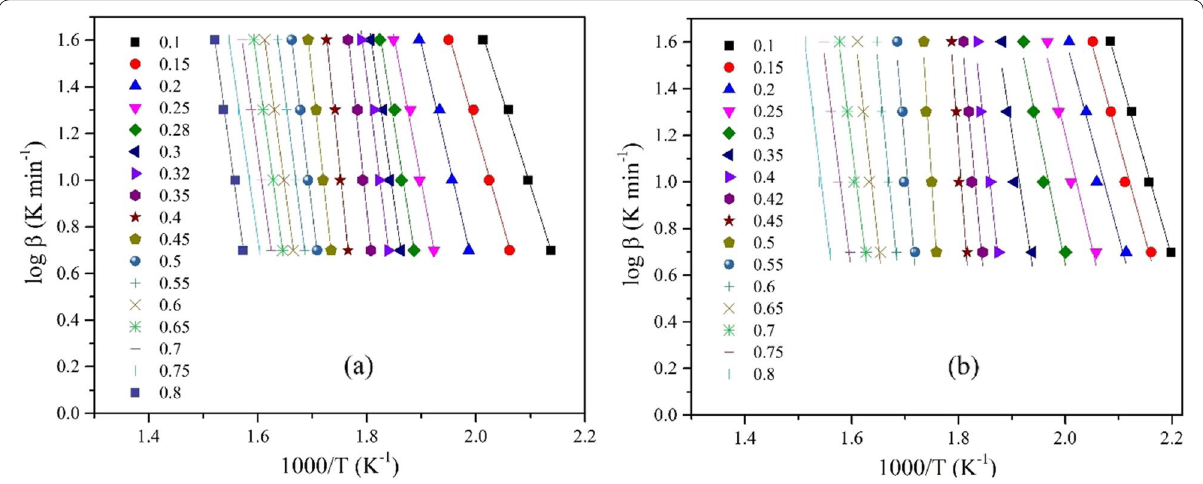
Fig. 7 Plot of log β versus 1000/T at conversion varied from 0.1 to 0.8 for spherical CNC (a) and rod-like CNC (CNC30)